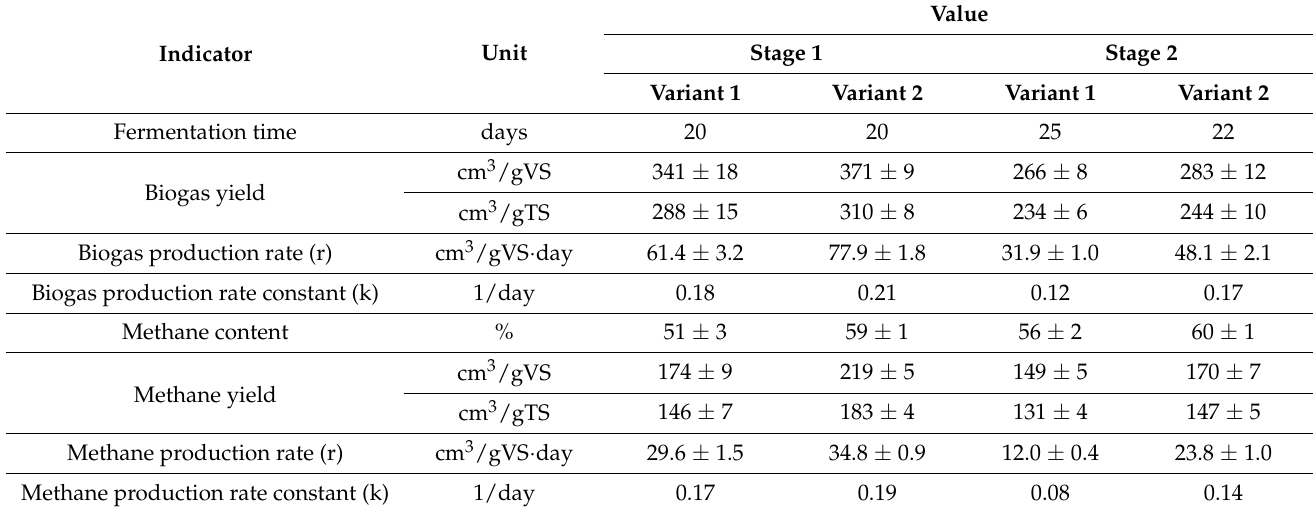
Table 6. Indicators characterizing the course of methane fermentation of hydrophyte